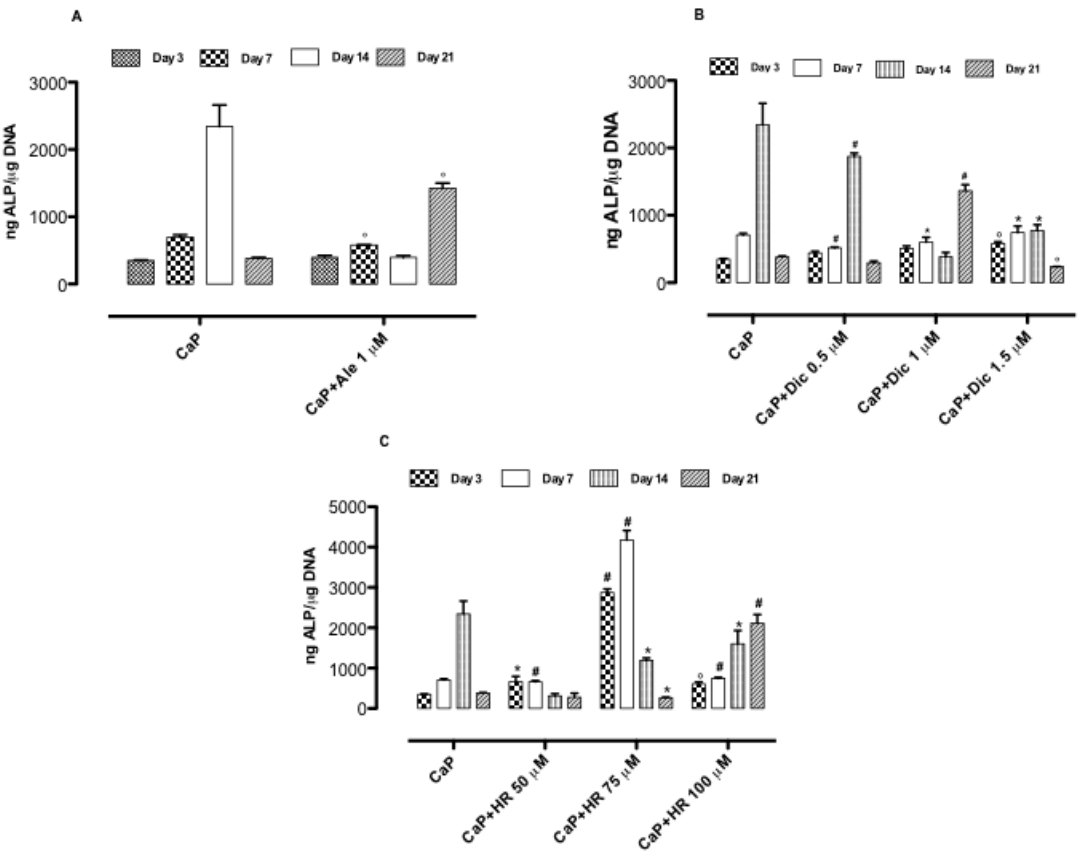
Figure 4. Alkaline phosphatase activity after 3, 7, 14, and 21 days of cell–materials interaction: CaP + Ale ( A ), CaP + Dic ( B ), and CaP + HR ( C ). Data represent mean ± dev.st. of three independent experiments ( n = 6). * p < 0.05; ° p < 0.01; # p < 0.001 vs. CaP.